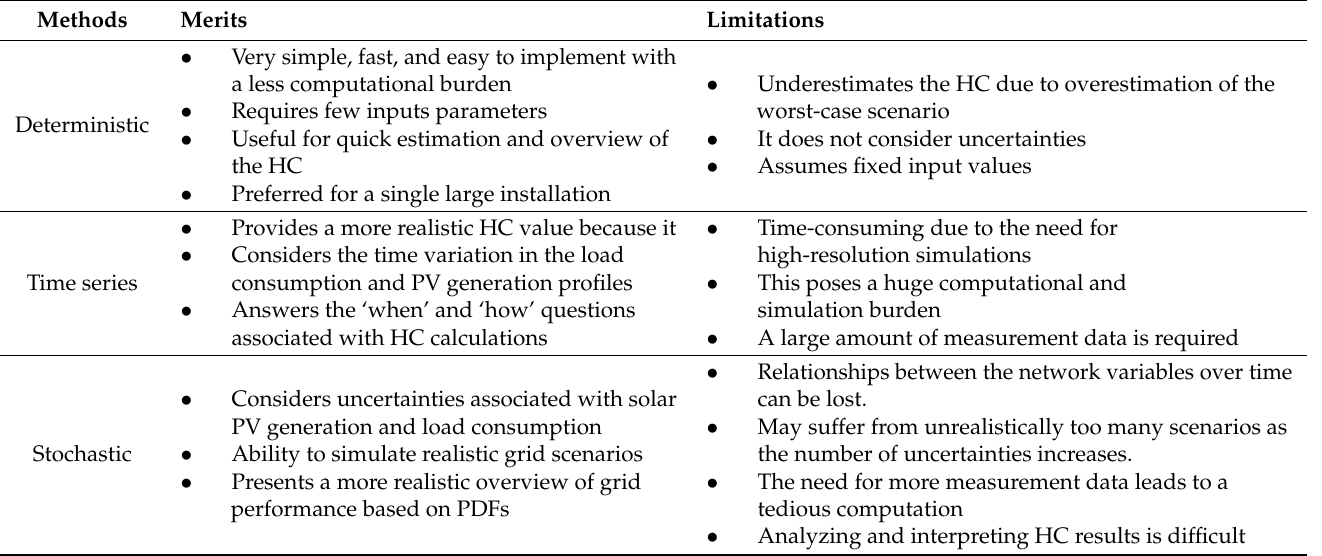
Table 7. Merits and limitations of the HC determination methods.